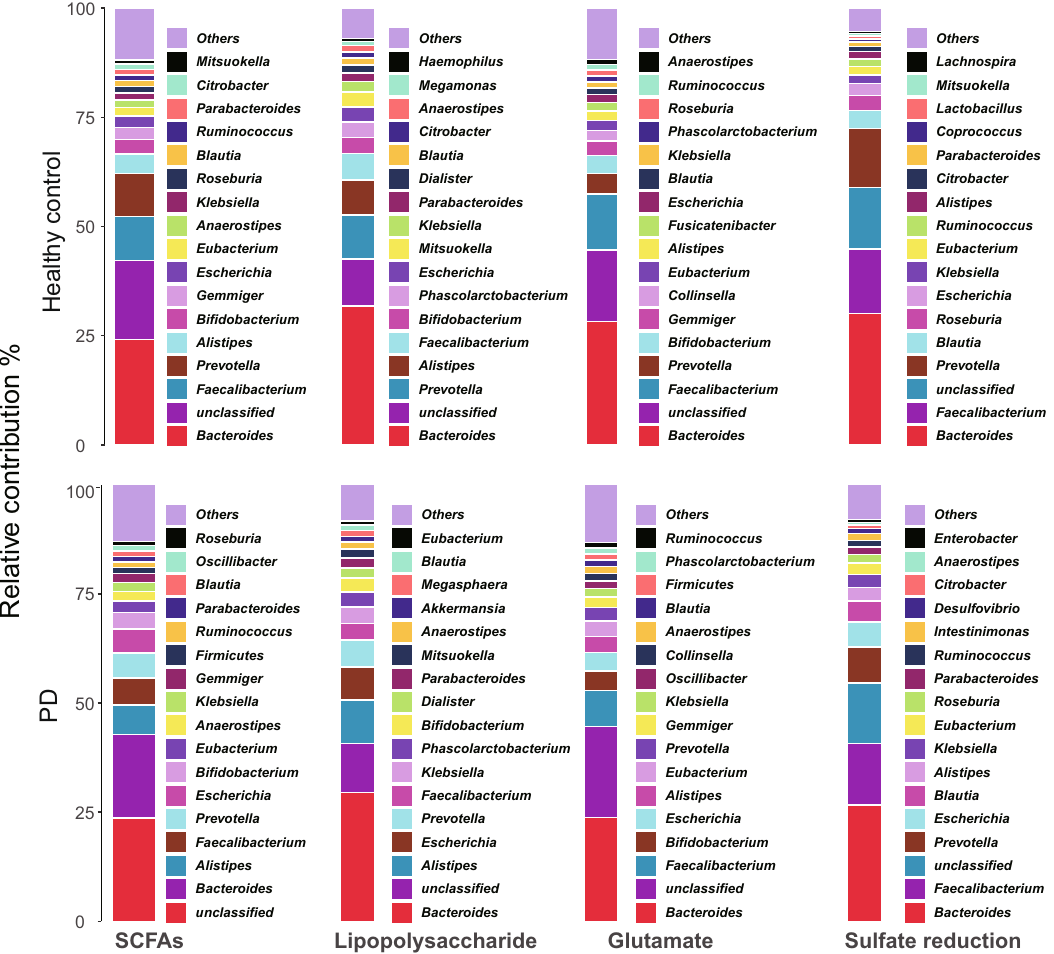
Fig. 4 The contribution rate of genera to the four in fl ammation-related metabolic genes. The value is the mean contribution rate in two Metagenomic datasets (M1 – 2). Parkinson ’ s disease (PD). SCFAs short-chain fatty